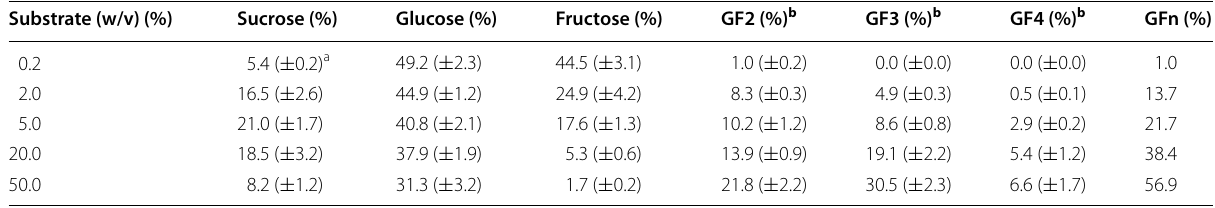
Table 1 HPLC analysis of FOS yield and composition produced by the FFase of A. tubingensis XG21 at different substrate